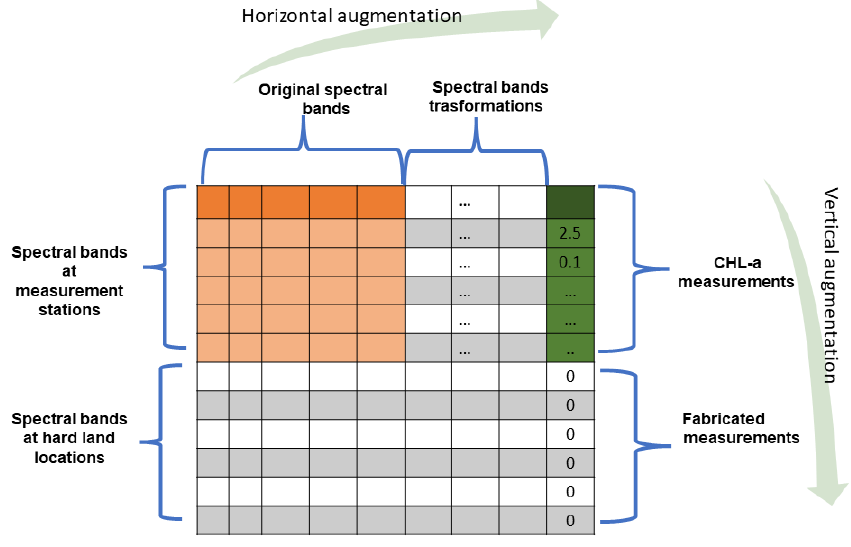
Figure 5. Illustration of two axes of augmentation performed on original data